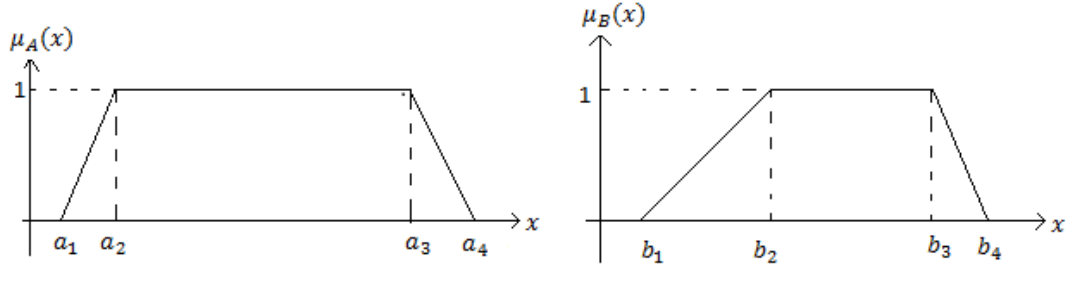
Figure 2. Graphs of trapezoidal fuzzy numbers 𝐴 and 𝐵